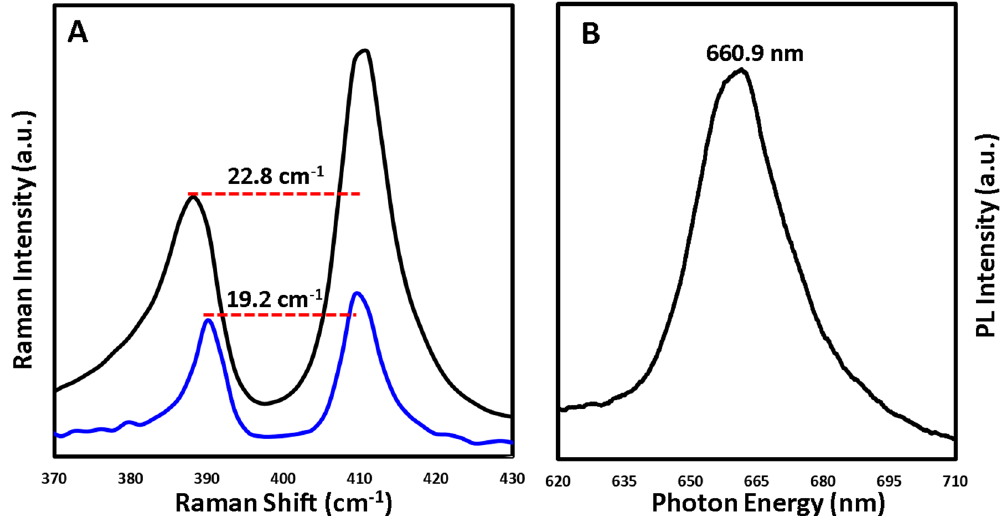
Figure 4. ( A ) Raman spectra of monolayer and few layers of MoS 2 . ( B ) PL characterization of MoS 2 thin